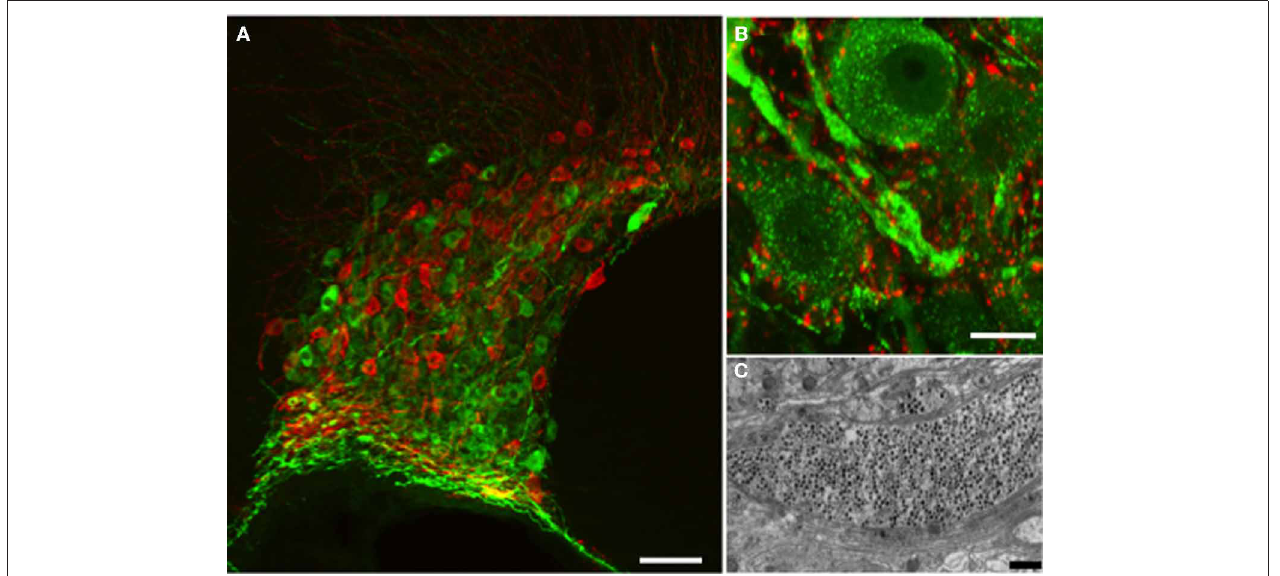
FIGURE 1 | Vasopressin and oxytocin are synthesized by a few thousand large (magnocellular) neurons (vasopressin cells are immunostained with fluorescent green and oxytocin cells with fluorescent red) whose cell bodies are located mainly in the supraoptic (A) and paraventricular (not shown) nuclei of the hypothalamus. (B) The vasopressin immunostaining is punctate and represents individual or aggregates of large dense-cored vesicles. In the dendrite thickenings the vesicles are particularly